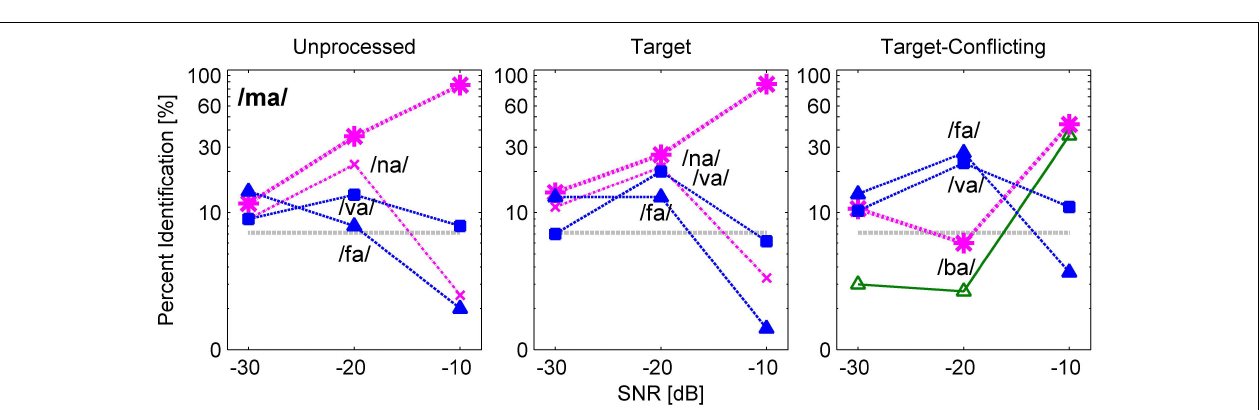
FIGURE 6 | Confusion patterns when /fa/ was presented. Each signal processing condition is given as a title above each panel. The presented consonant is given in the left panel, and all dependent values are plotted on a logarithmic scale as a function of SNR. The percent correct scores for the presented consonant are denoted as a thick curve, whereas the percent scores for each non-presented consonant or competitors are indicated as a thin curve with labels. Only up to top three competitors are shown for a better visualization of the confusion patterns.